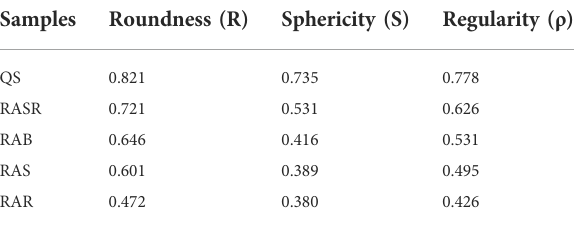
TABLE 2 Computed shape parameters of samples.